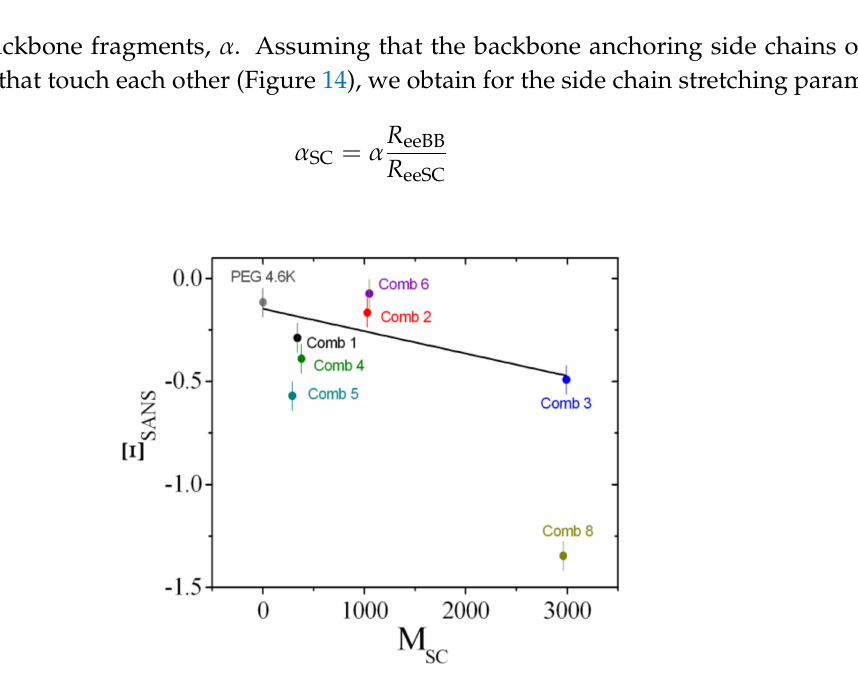
Figure 13. The sensitivity of the bending rigidity, Ξ SANS , as a function of the side chain molar mass, M SC . The values are determined from the small-angle neutron scattering measurements. We did not perform SANS measurements on Comb 7. The line is a guide for the eye that was fitted to the series: PEG, Comb 1, 2, and 3.